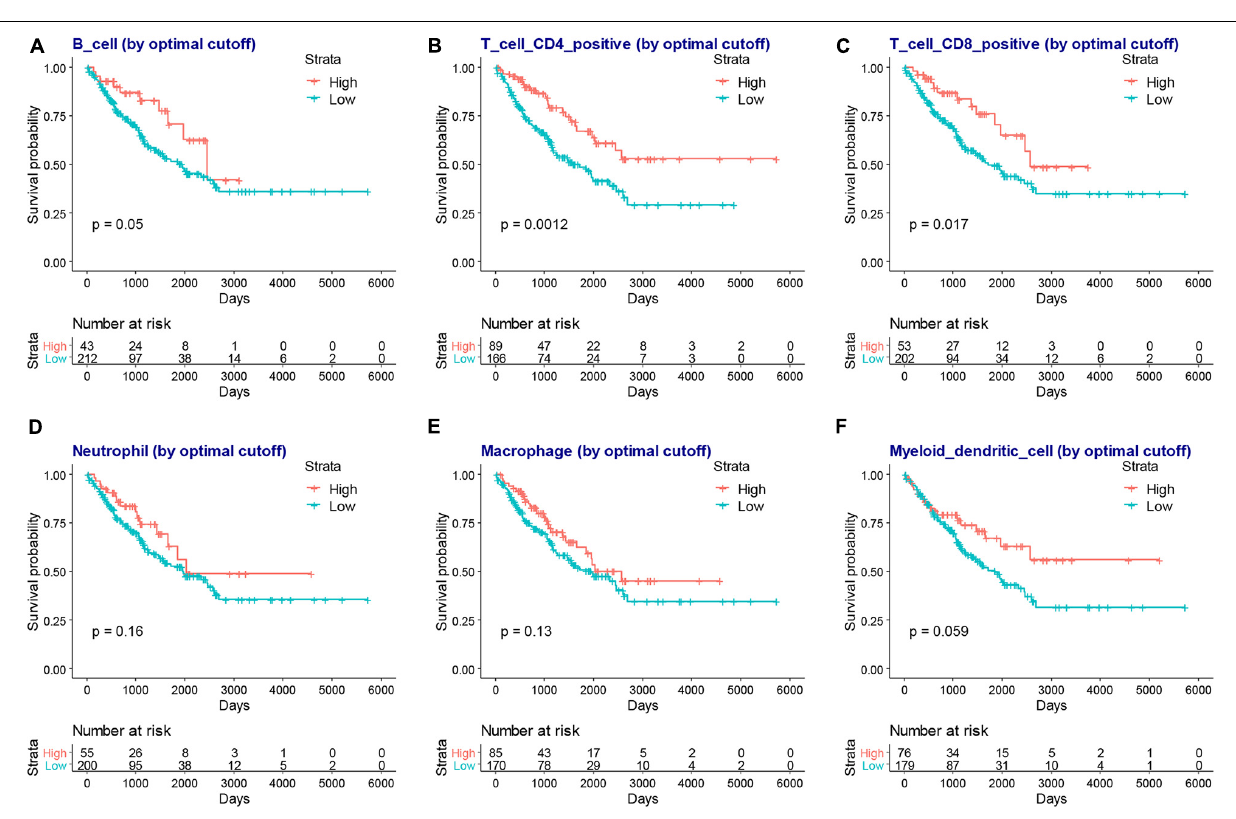
FIGURE 5 | The association between infiltration level of immune cells and the overall survival of patients with SARC. The KM plot of infiltration levels of B cells (A) , CD4+ T cells (B) , CD8+ T cells (C) , neutrophils (D) , macrophages (E) , and myeloid dendritic cells (F) and the overall survival of patients with